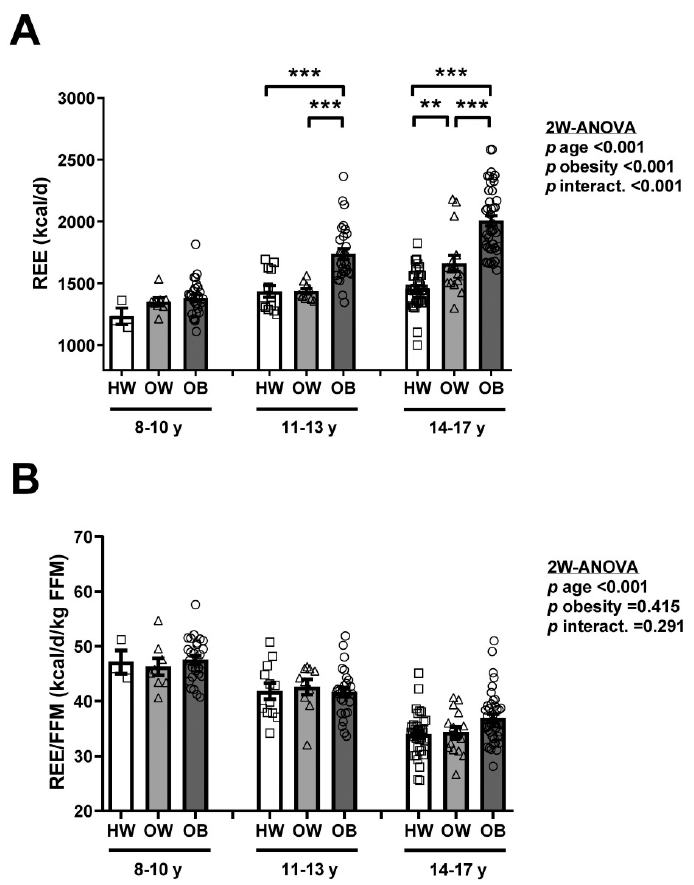
Figure 4. Comparison of absolute REE ( A ) and normalized by FFM ( B ) in the whole sample of children and adolescents ( n = 181) segregated by age and weight groups (healthy weight, overweight and obesity). Values are means ± SEM. Differences between groups were analyzed by two-way ANOVA (age x obesity). Differences between groups of healthy weight, overweight and obesity within each age group were analyzed by ANOVA followed by LSD tests. ** p < 0.01 and *** p < 0.001 between groups. REE, resting energy expenditure; FFM, fat-free mass. HW, healthy weight; OW, overweight; OB, obesity.